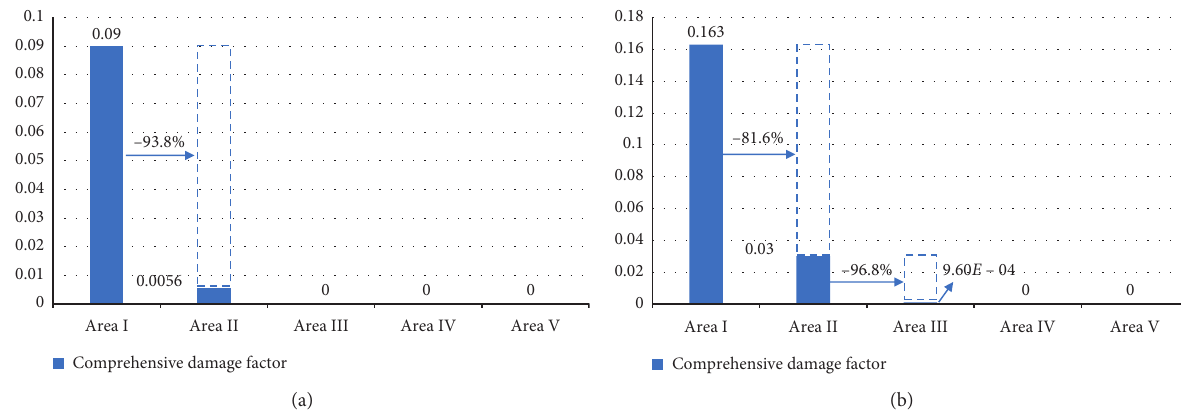
Figure 11: Comparison of average comprehensive damage factors in the axial direction: (a) SFRC and (b) ordinary